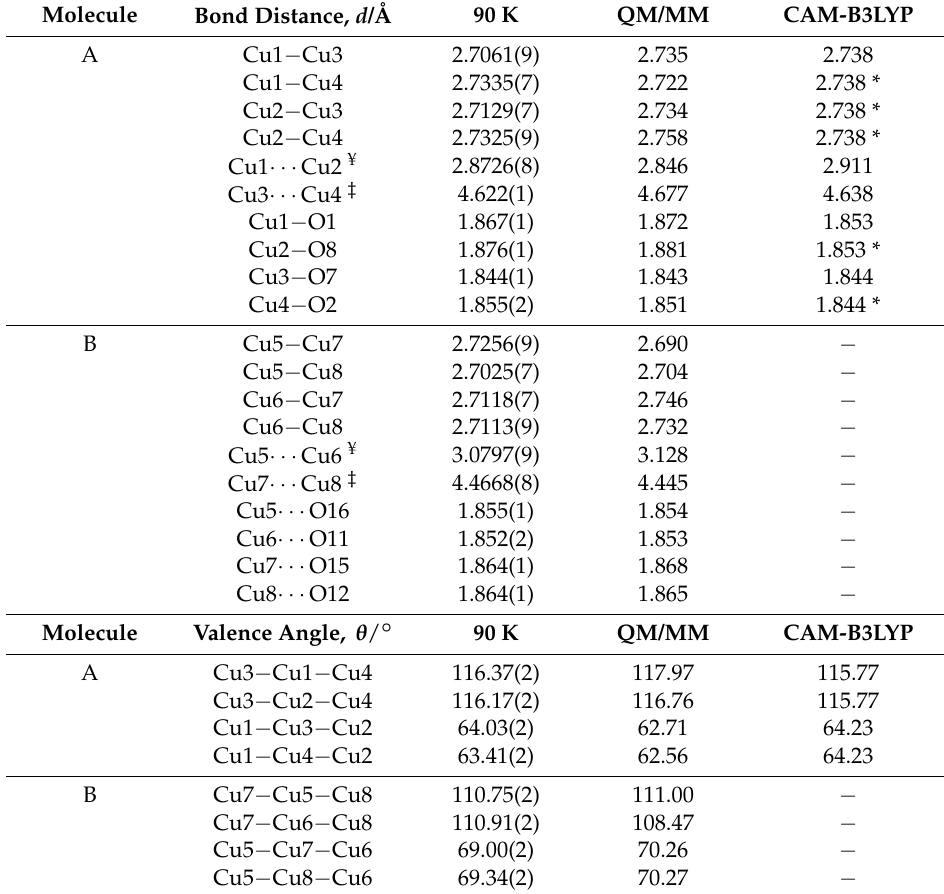
Table 5. Selected distances and angles for Cu 4 : in ground state (S 0 ): comparison of experiment and theory. 90 K denotes experimental results (Table 1); QM/MM denotes modelled solid-state structures; CAM-B3LYP denotes theoretical isolated-molecule results (shown only once for molecule A